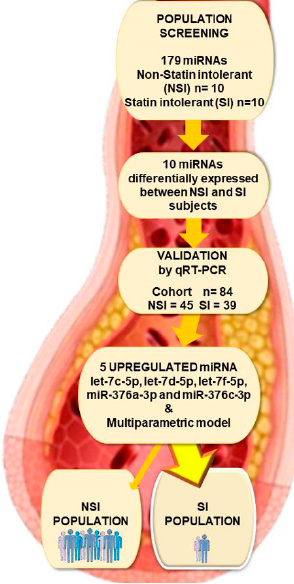
Figure 7. The flowchart of the study design. This figure illustrates the experimental workflow of the study including screening and validation. MiRNA: microRNA; NSI: non-statin intolerant; SI: statin